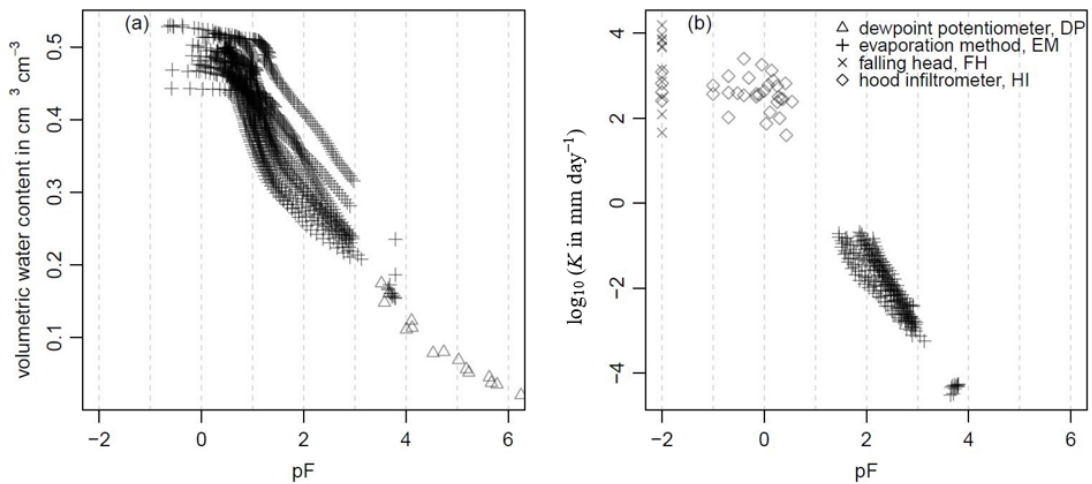
Figure 1. Example of measurements for hydraulic soil properties to illustrate ranges of different methods; 11 replicates measured in one treatment (site B, T1). Subplot ( a ) is the water retention curve θ ( h ) , ( b ) is the hydraulic conductivity curve K ( h ) . For both, h is transformed to pF by pF = log 10 | h |